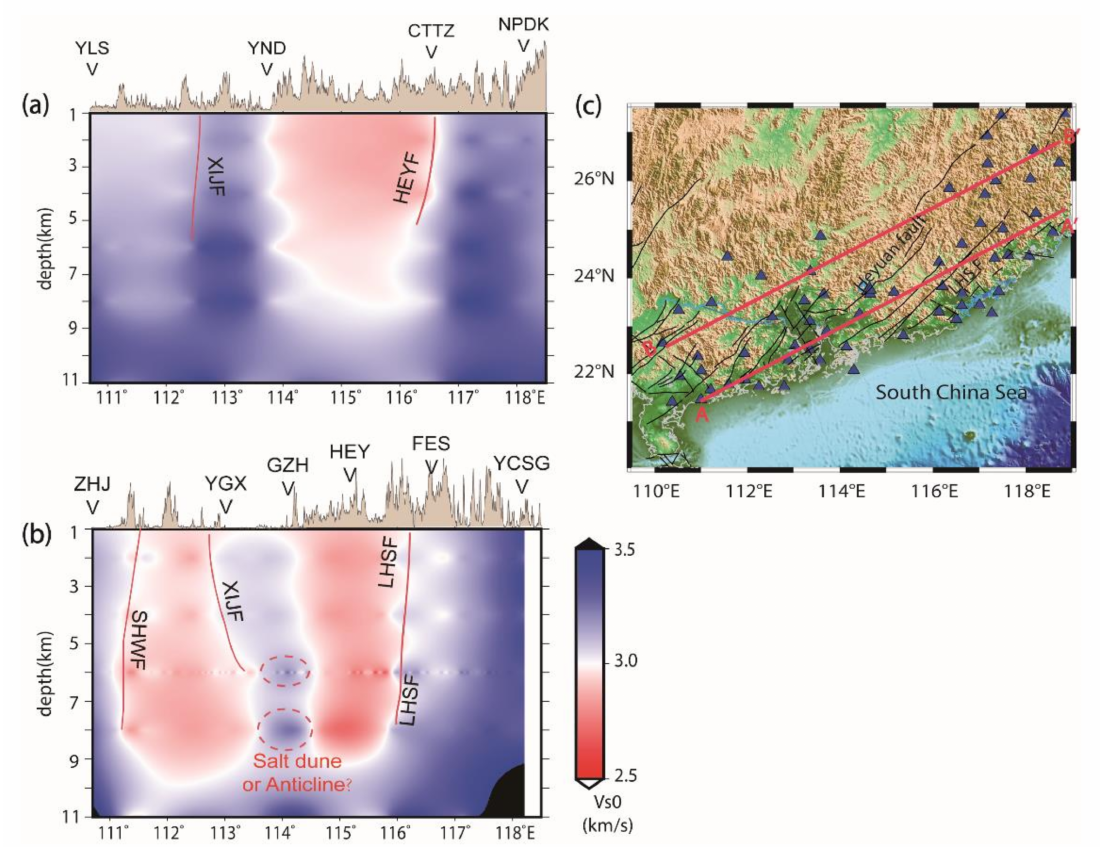
Figure 8. SWV structure profile parallel to the coastline. ( a ) SWV structure of the YLS-NPDK profile (BB’); ( b ) SWV structure of the ZHJ-YCSG profile (AA’); ( c ) locations of the two profiles. LHSF represents the Lianhuashan fault; SWCF represents the Sihui-Wuchuan fault. XIJF and HEYF represent the Xijiang fault and Heyuan fault,